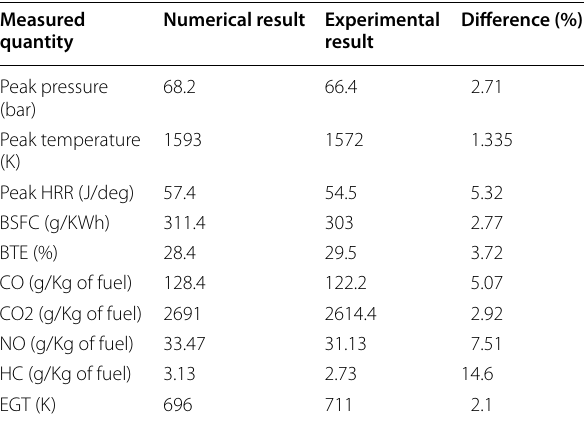
Table 8 Comparison of numerical and experimental results of